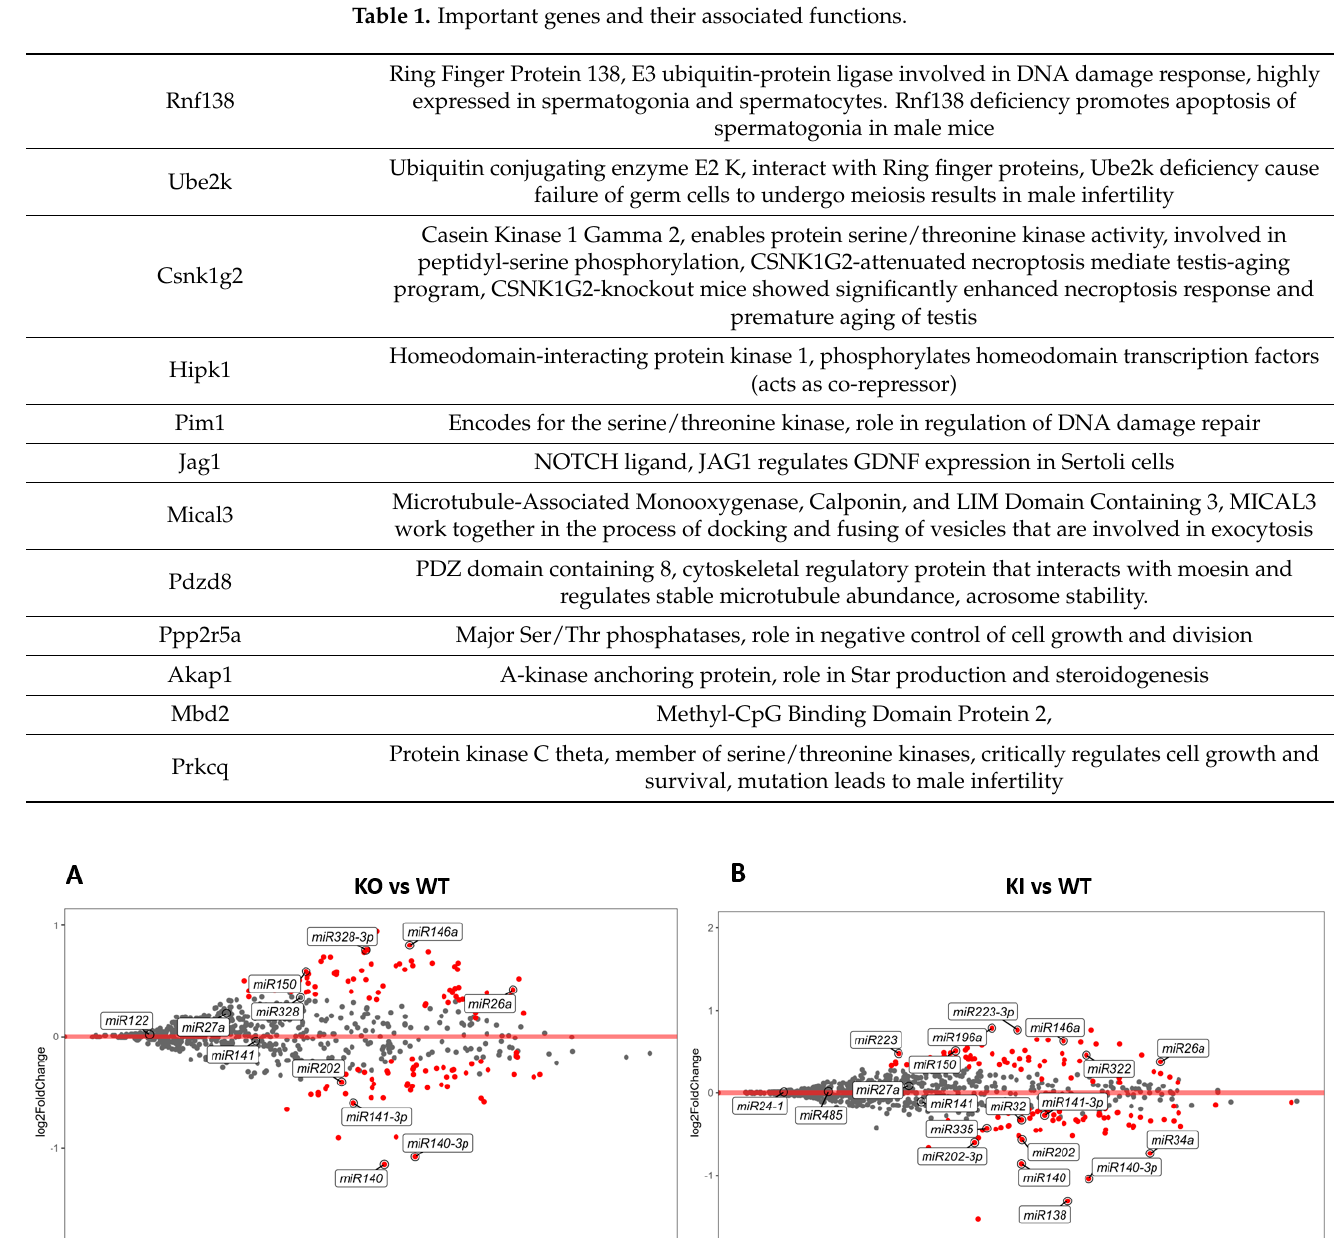
Table 1. Important genes and their associated functions.